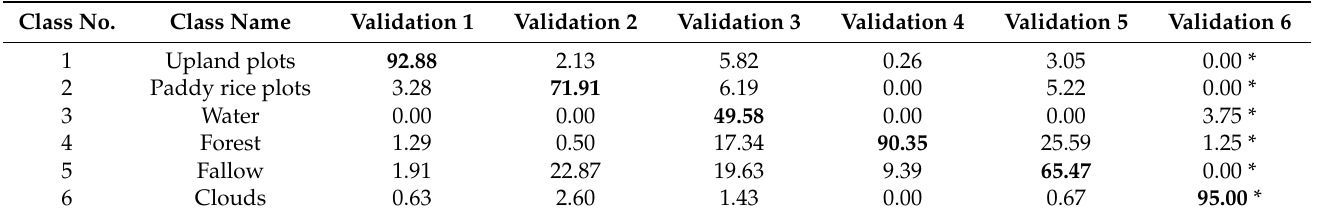
Table 2. RF image classification average accuracy matrix in the Houaylack-Vangven area.